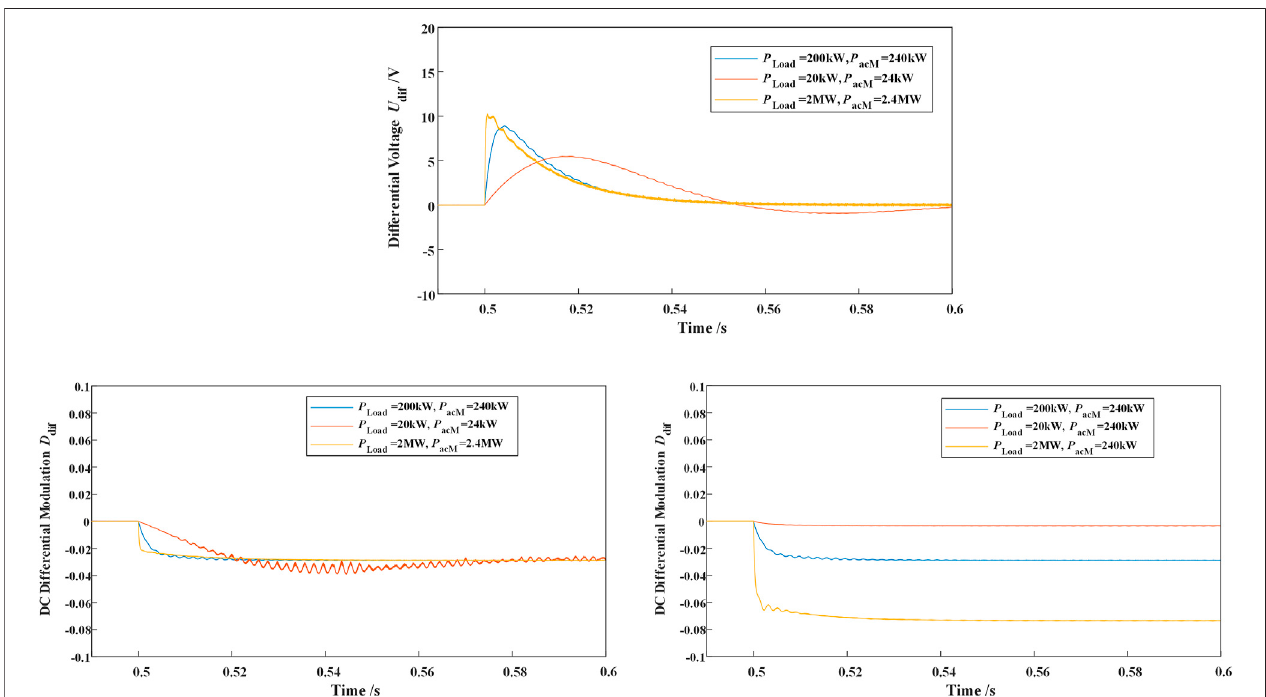
FIGURE 13 | Simulation results of bipolar balance with different load conditions.